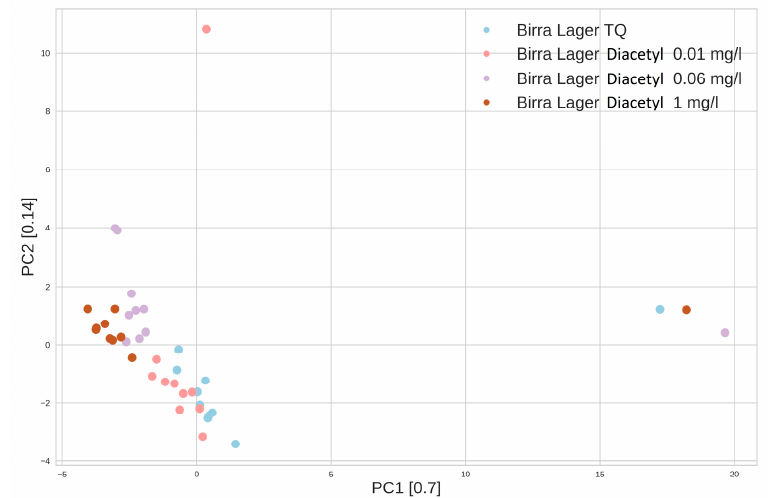
Figure 7. PCA between IPA and lager beers, unaltered and with 1 mg/L of diacetyl. Pink dots: IPA (US); brown dots: lager (US); light blue dots: IPA with 1 mg/L of diacetyl; purple dots: lager with 1 mg/L of diacetyl.